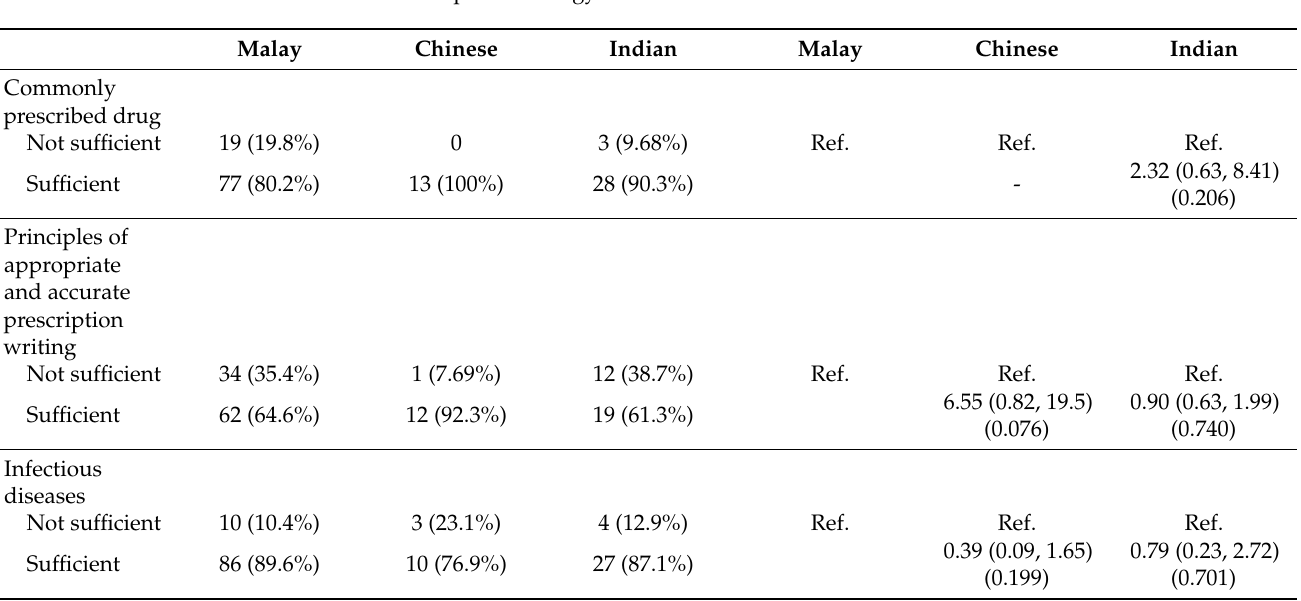
Table 4. Frequency and odds of ethnicity in the formal education and training sufficiency and confidence in